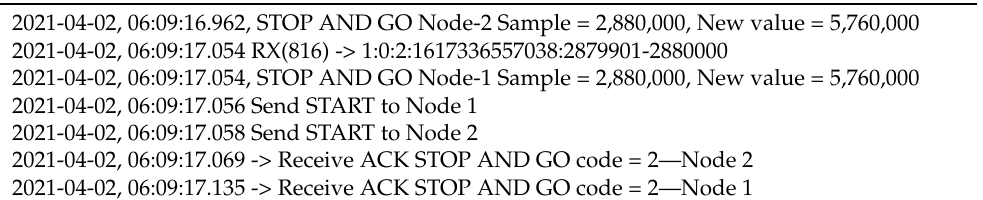
Table 4. Log of Stop-and-Go occurs.